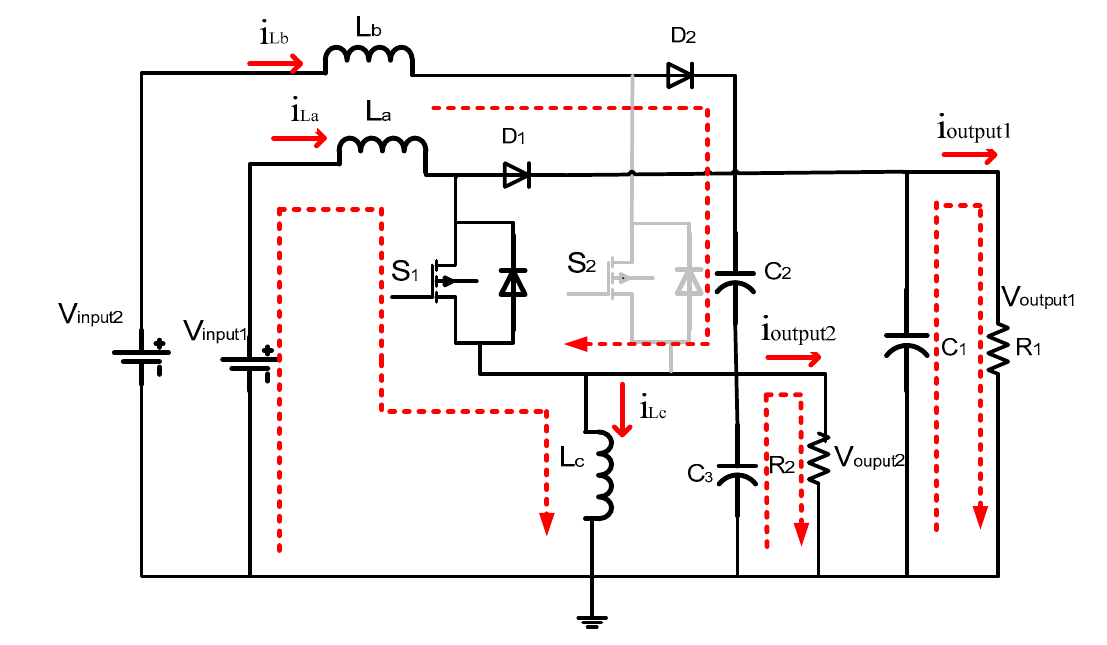
Figure 3. Mode 1 operation ( ---- Current flow direction).